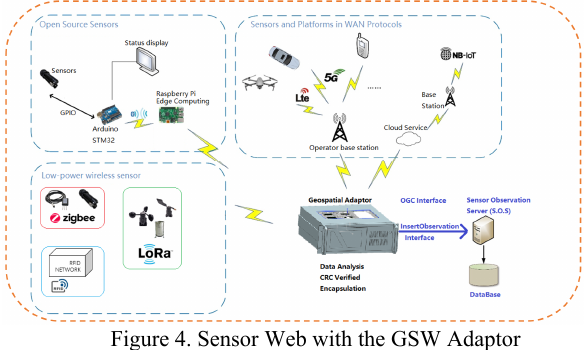
Figure 4. Sensor Web with the GSW Adaptor